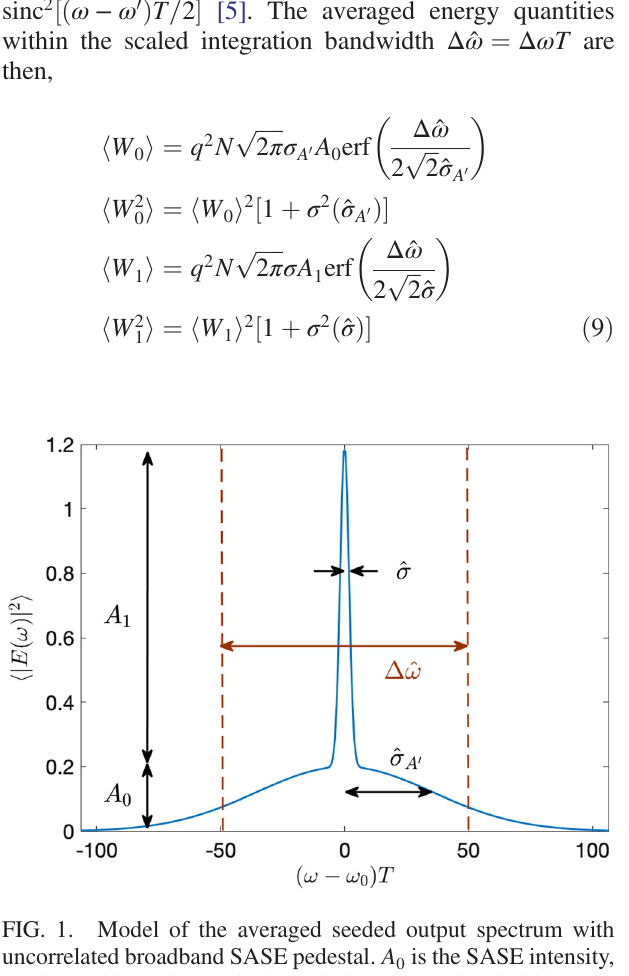
ˆ σ the FIG. 2. Variance σ 2 in Eq. (11) as a function of window Δ ˆ ω for different bandwidths ˆ σ